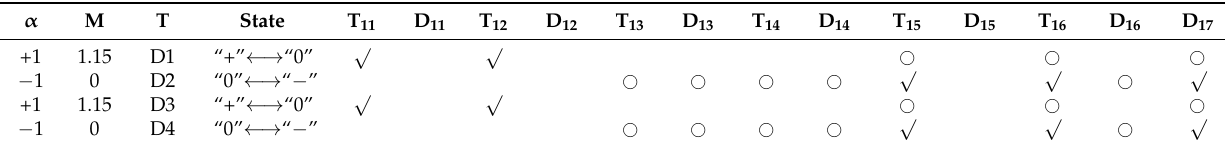
Table 5. ID-NPC switching loss table.